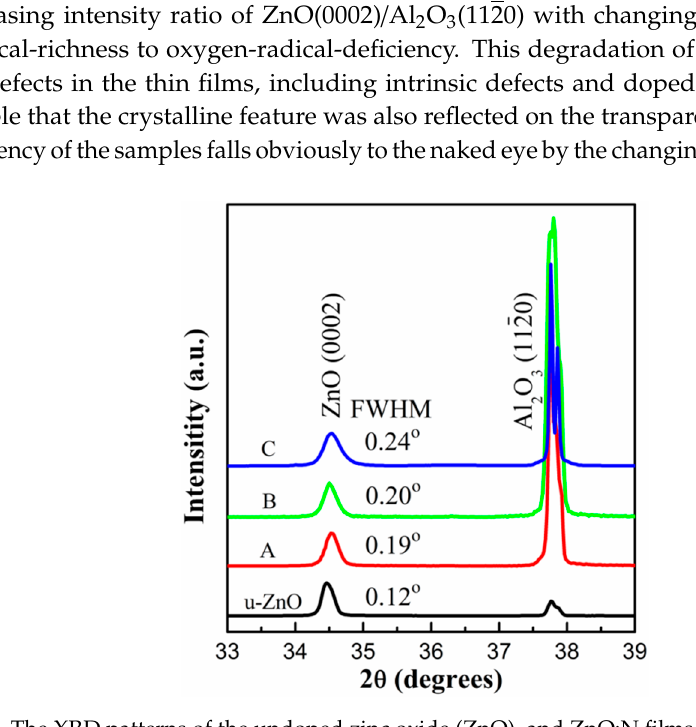
= 0.4, F = 0.8 NO N2